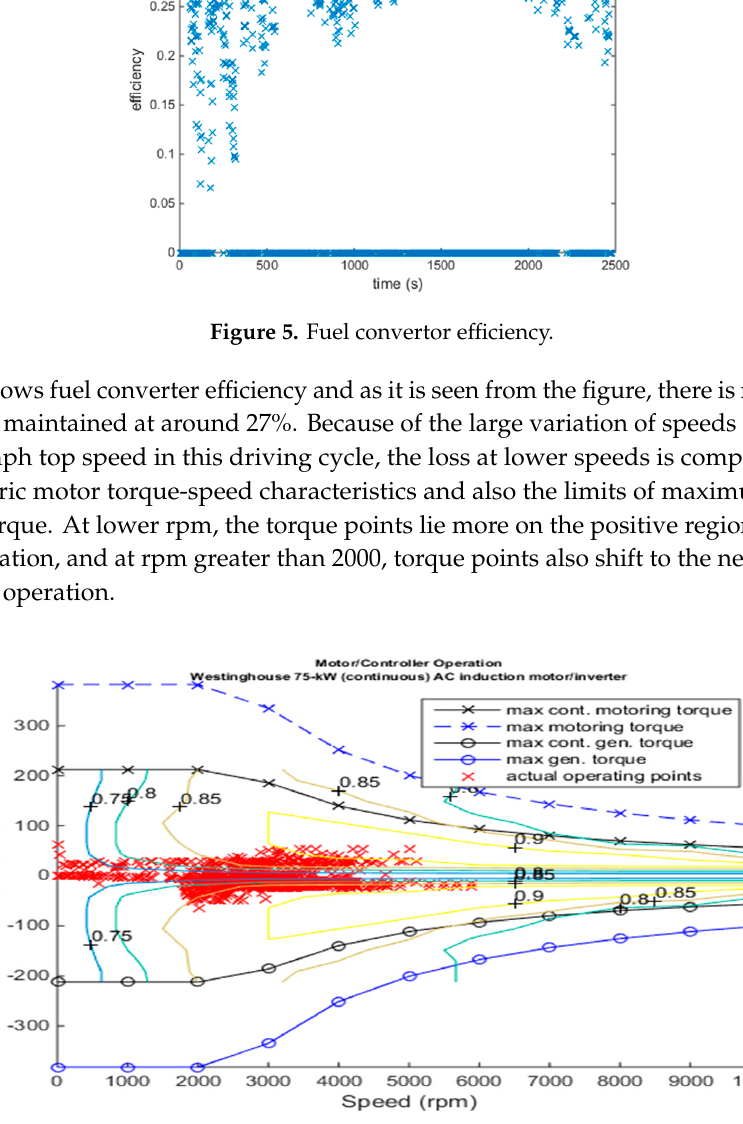
Figure 4. State of Charge (SOC) history.